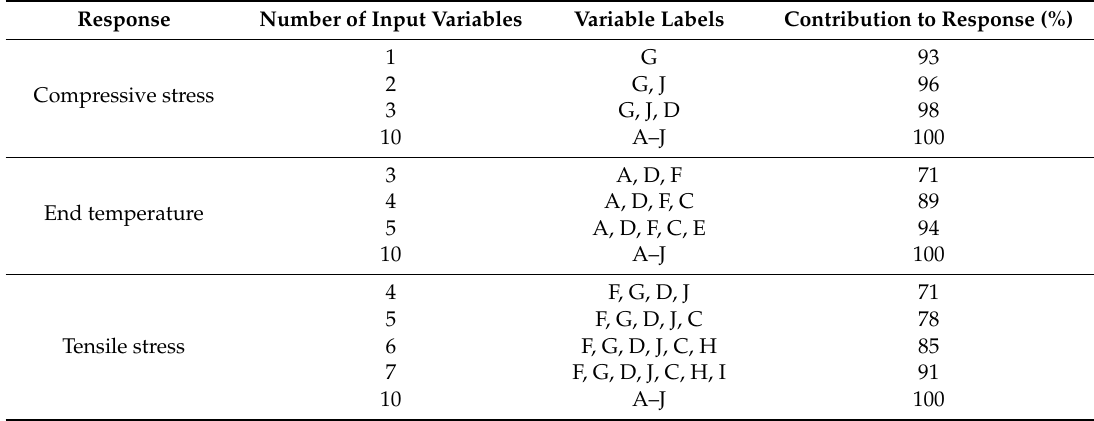
Table 3. Variable combinations of each response for backpropagation (BP)-ANN